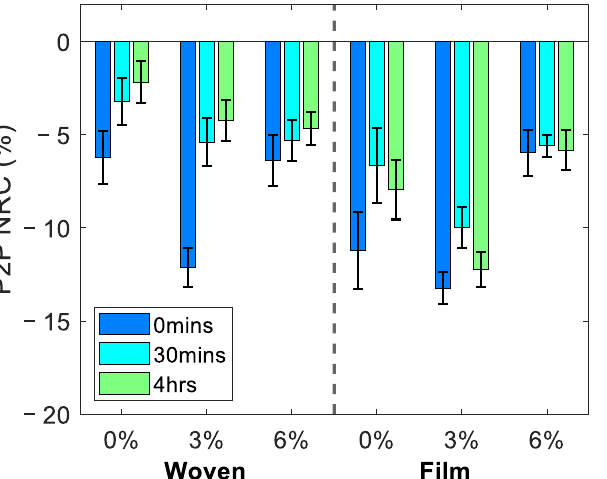
Figure 5. The average normalised relative change (NRC) in the P2P sampled 52 s into occlusion, observed in all five subjects at 0 min, 30 min and four hours following the removal of the woven- and film-backed patches containing 0%, 3% and 6% propylene glycol. The error bars are the standard error on the